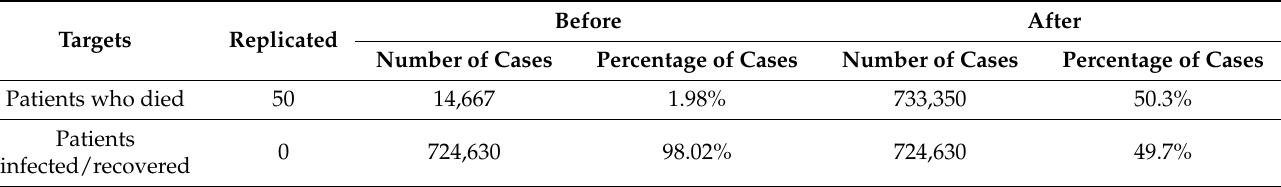
Table 5. Distribution of cases using Oversampling.